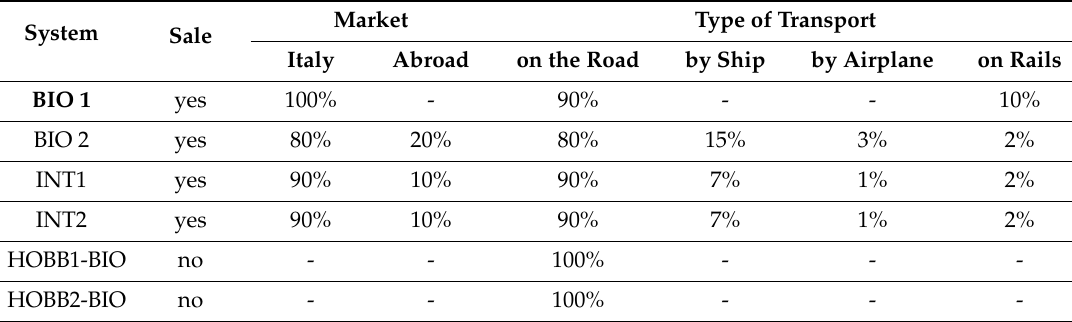
Table 6. Details of olive oil sale for each analyzed